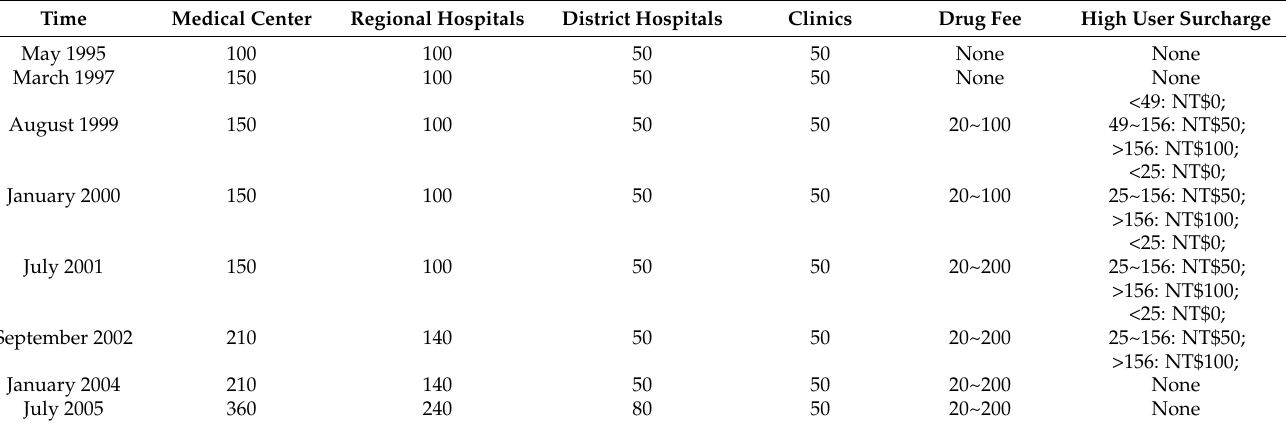
Table A1. Copayment Changes for Outpatient Services and Medications under Taiwan National Health